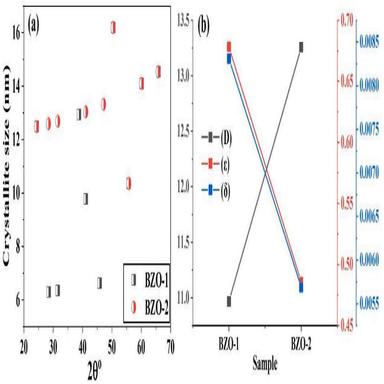
(a) Shows the crystallite size of the two BZO samples calculated using Debye-Scherrer's equation, and (b) depicts the correlation between crystallite size, lattice distortions, and dislocation density in the BZO composite samples.